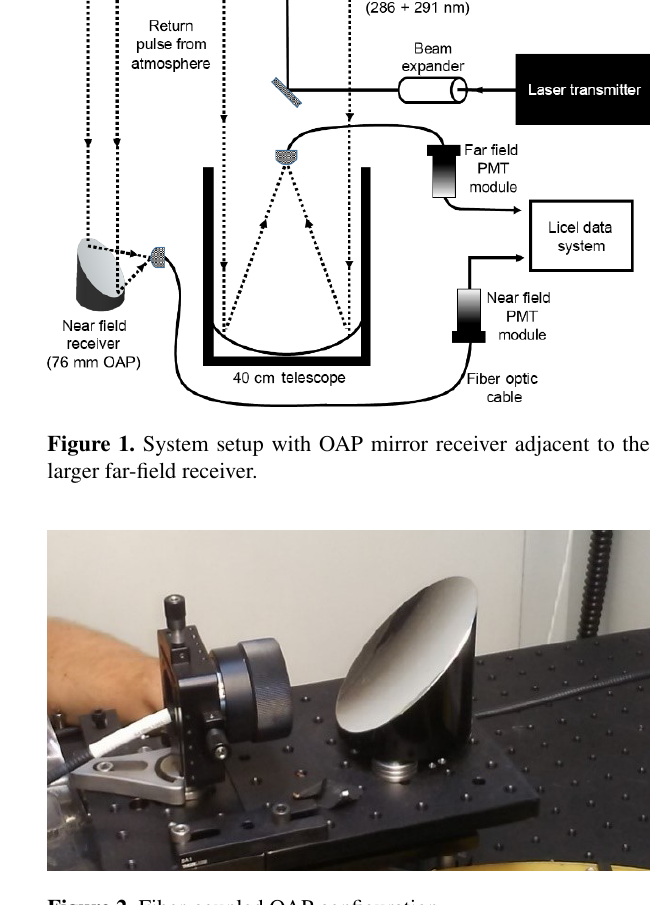
Figure 2. Fiber-coupled OAP